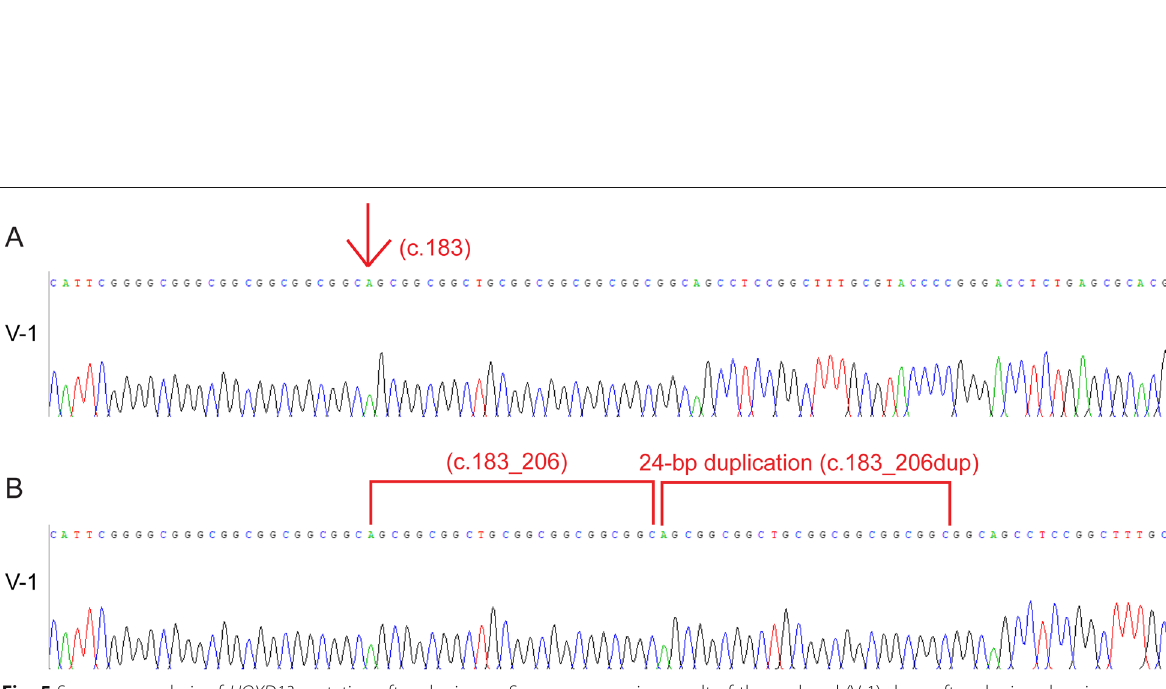
Fig. 5 Sequence analysis of HOXD13 mutation after cloning. a , Sanger sequencing result of the proband (V-1) done after cloning showing normal sequence. b , Sanger sequencing result of the proband (V-1) done after cloning showing 24-base pair of